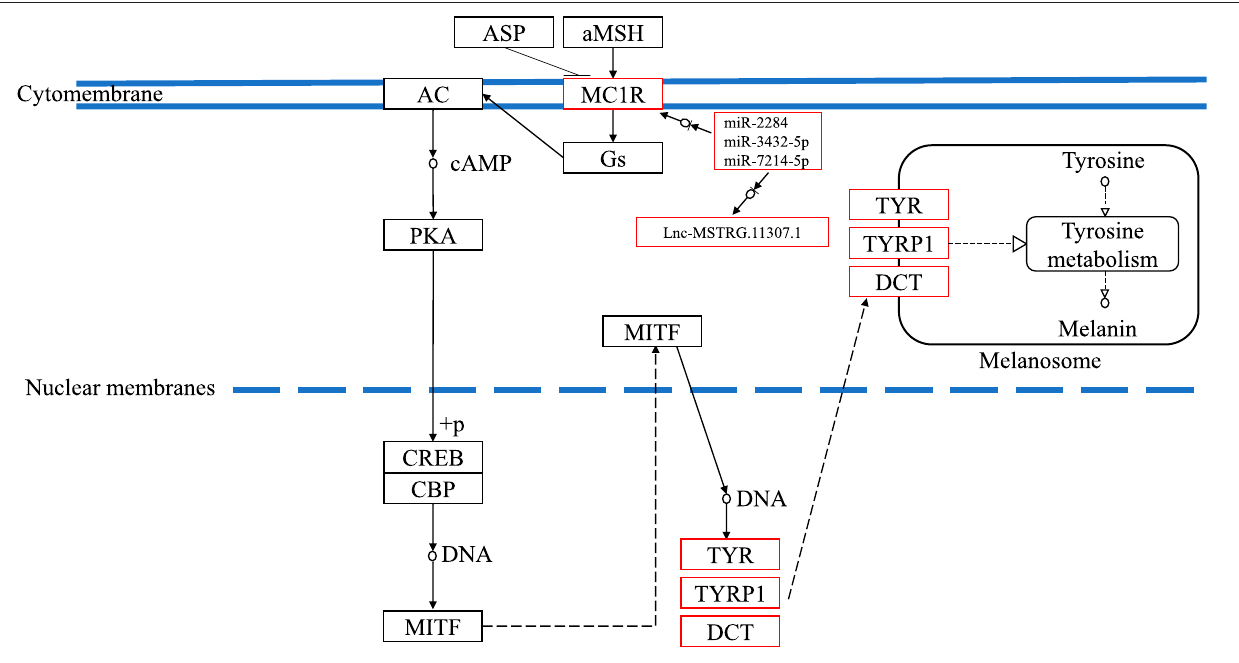
FIGURE 9 | The underlying ceRNA mechanism of blind-side hypermelanosis in melanogenesis pathway in tongue sole.